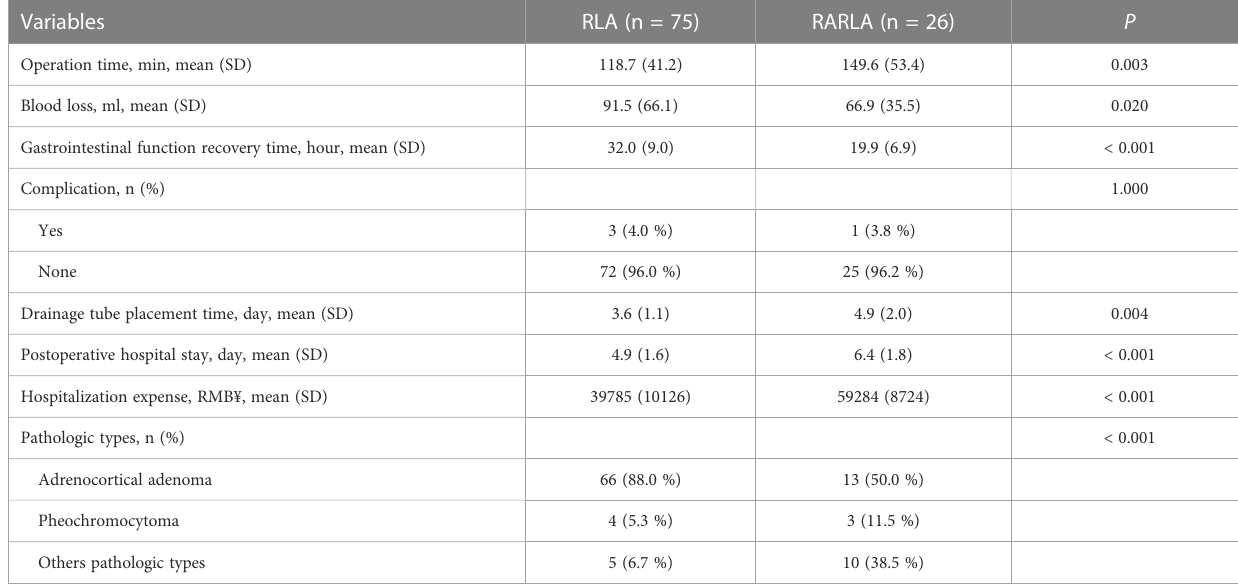
TABLE 2 Comparison of perioperative and pathological